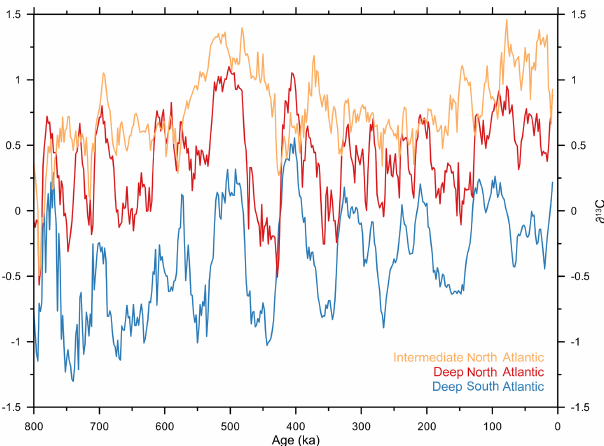
Figure 8. Regional ∂ 13 C stacks. Stacked records of benthic ∂ 13 C separated into three regions: intermediate North Atlantic (orange), deep North Atlantic (red), and deep South Atlantic (blue). All plots are shown in ∂ 13 C space to highlight different isotopic